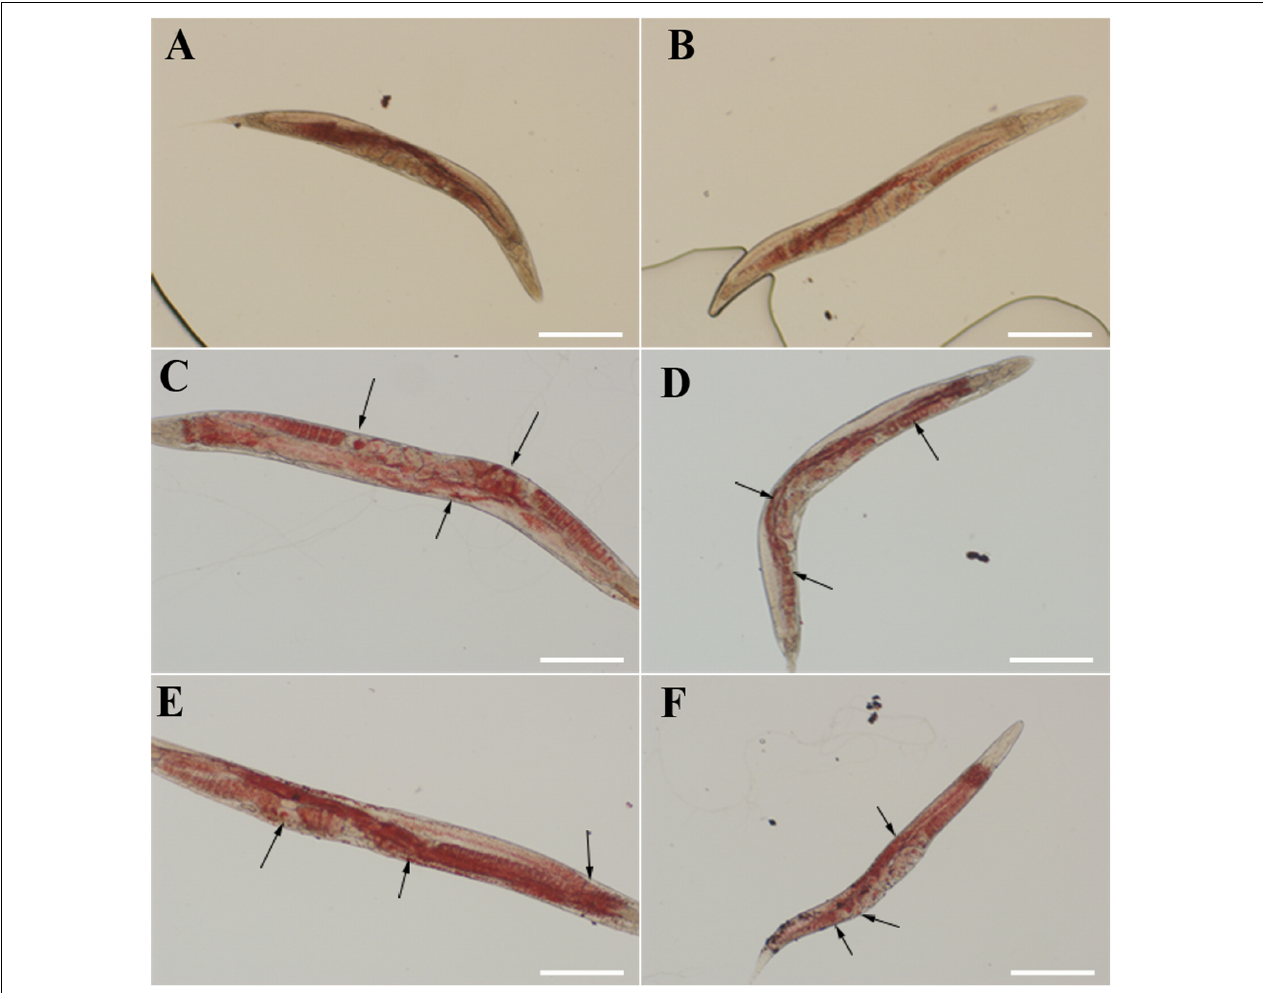
FIGURE 4 | Fat storage in rescued daf-22 mutant ( ok693 ), N2 strain and ok693 were used as controls. The lipid staining was performed flowing the protocol described in the methods. Worms were placed on a microslide and observed using a differential interference contrast microscope. The figure showed that the fat granules reduced significantly or disappear in the Hc-daf-22 rescued worms, while there were still many fat granules in the worms of Hc-daf-22 -84S/299A/349A rescued worms. (A) fat storage in N 2 strain; (B) fat storage in Hc-daf-22 rescued ok693 ; (C) fat storage in Hc-daf-22 -84S rescued ok693 ; (D) fat storage in Hc-daf-22 -299A rescued ok693 ; (E) fat storage in Hc-daf-22 -349 rescued ok693 ; (F) fat storage in daf-22 mutant ( ok693 ). Arrows represent fat granules in the worms. Scale-bars : 200 µ